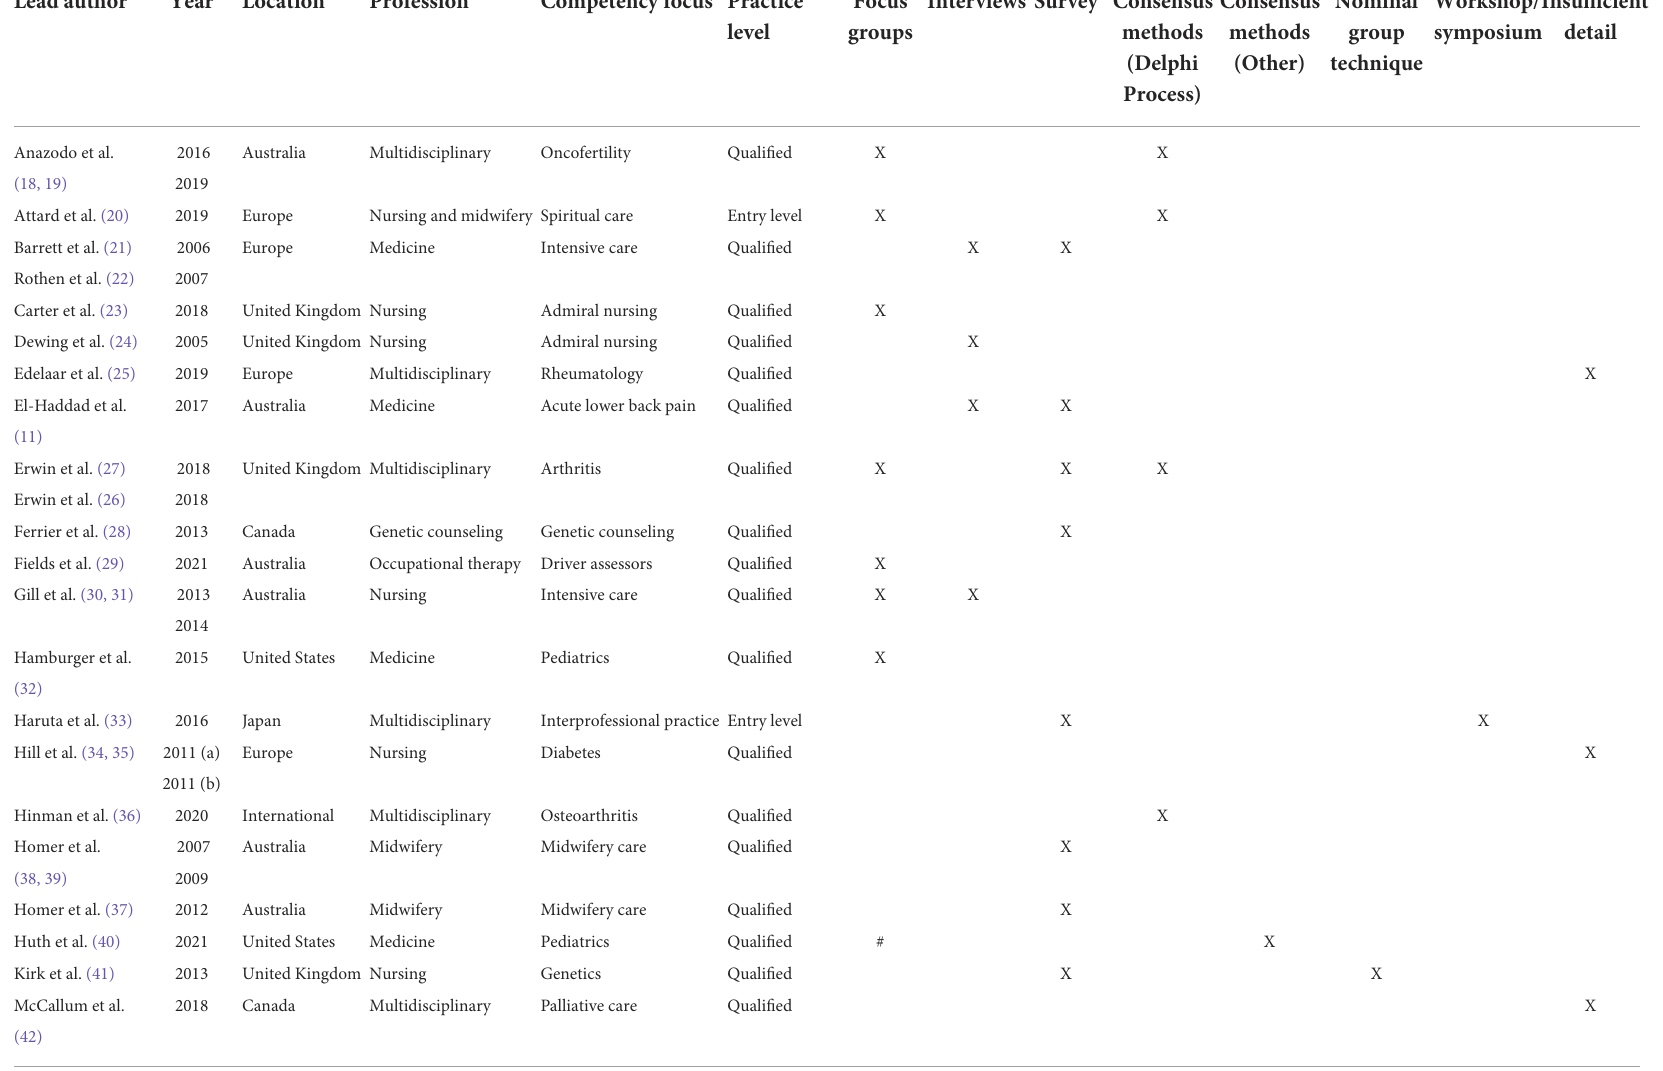
TABLE 2 Study characteristics and methods used for patient and public involvement. Lead